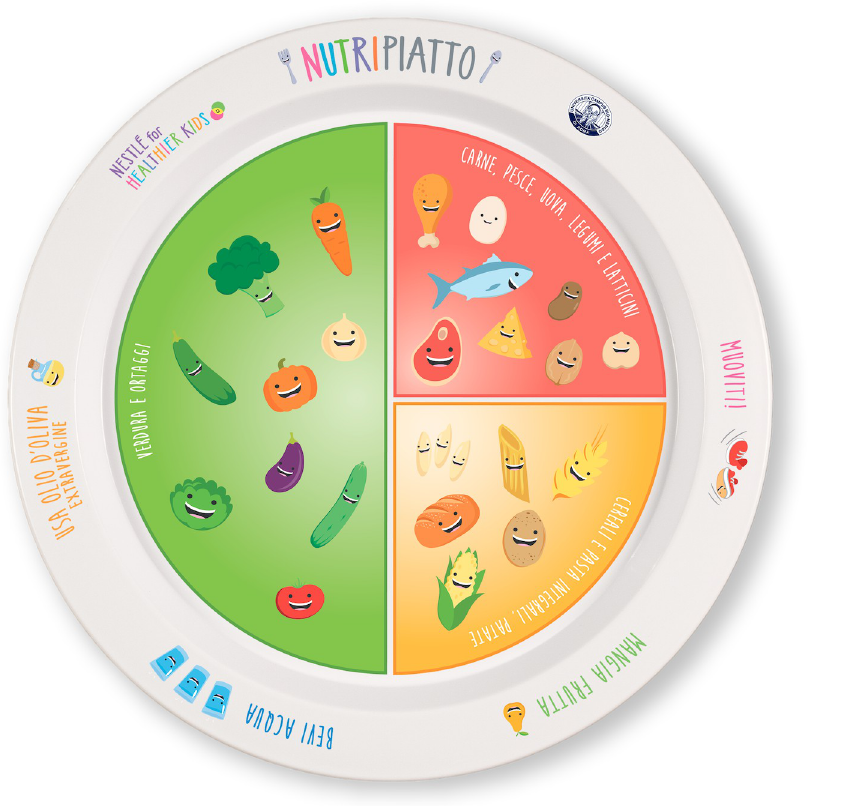
Fig 1. “Nutripiatto”, a visual plate. A tool for nutritional education for children aged 4–12 years.